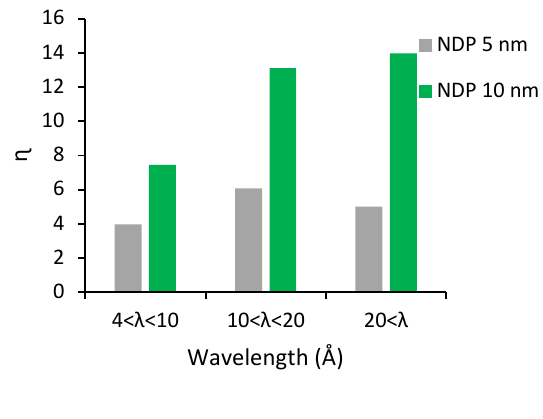
Fig. 13. Ratio of neutron increase using NDP in CNS.